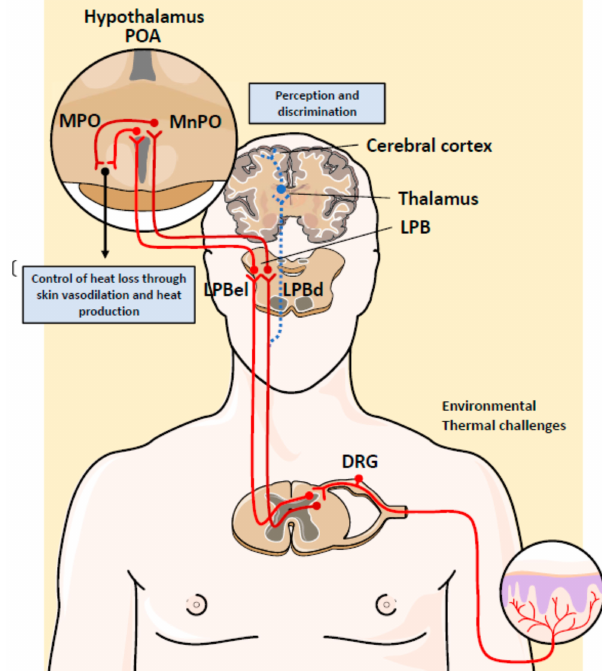
Figure 3. Hypothalamic thermoregulatory network that controls body temperature in mammals. The hypothalamic neurons of the preoptic area (POA) and the posterior hypothalamic area function as a body thermostat to maintain a stable body temperature. The ascending temperature information ends in two anatomically distinct areas of the lateral parabrachial nucleus (LPB): the lateral and dorsal external LPB (LPBel and LPBd, respectively). Heat and cold have been shown to activate cFOS expression in LPBd and LPBel, respectively. Altogether, this sophisticated thermoregulatory network highlights the importance of maintaining body temperature during an environmental temperature challenge. DRG, dorsal root ganglia; MPO, medial preoptic subnucleus; MnPO, median preoptic